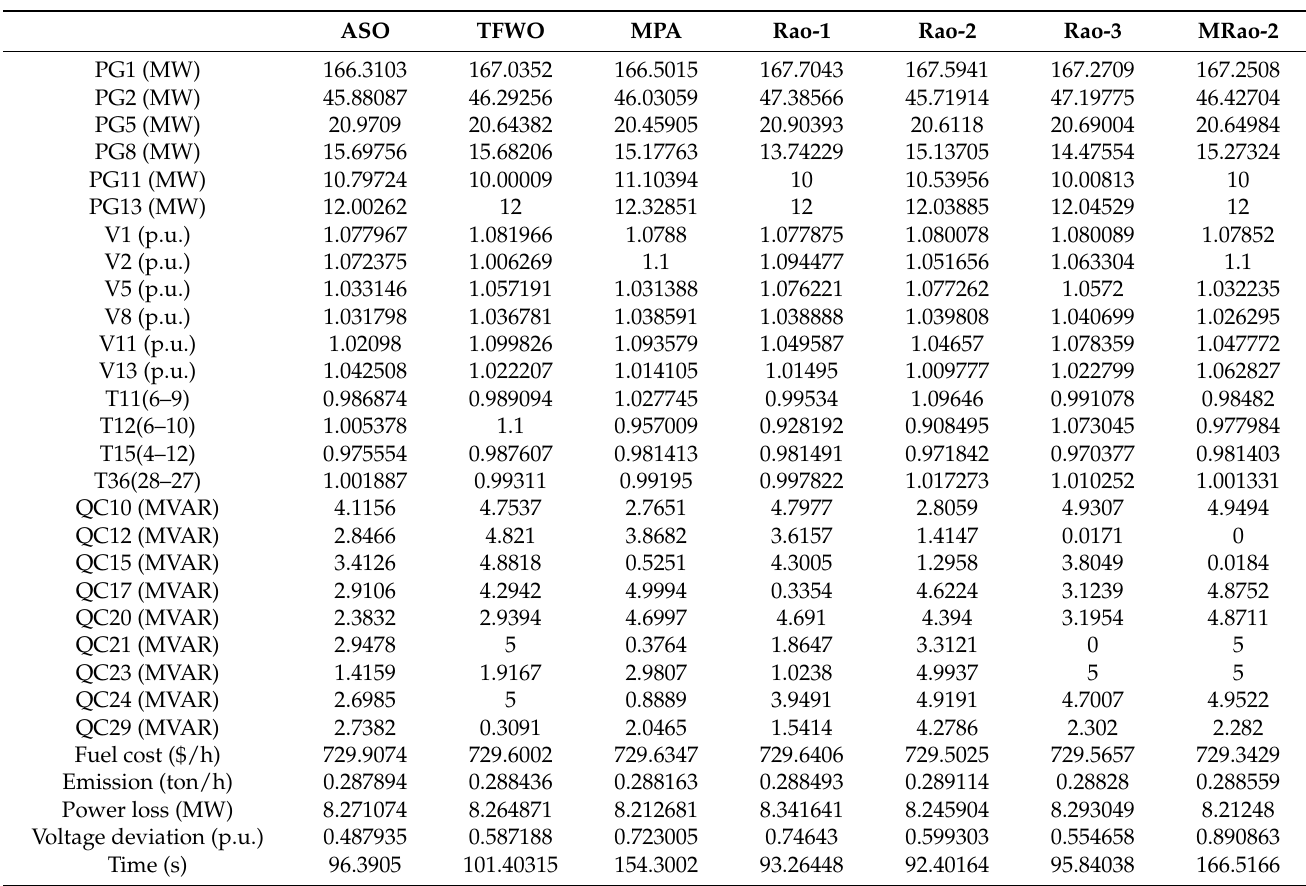
Table 6. Results of the proposed MRao-2 algorithm and other algorithms for case